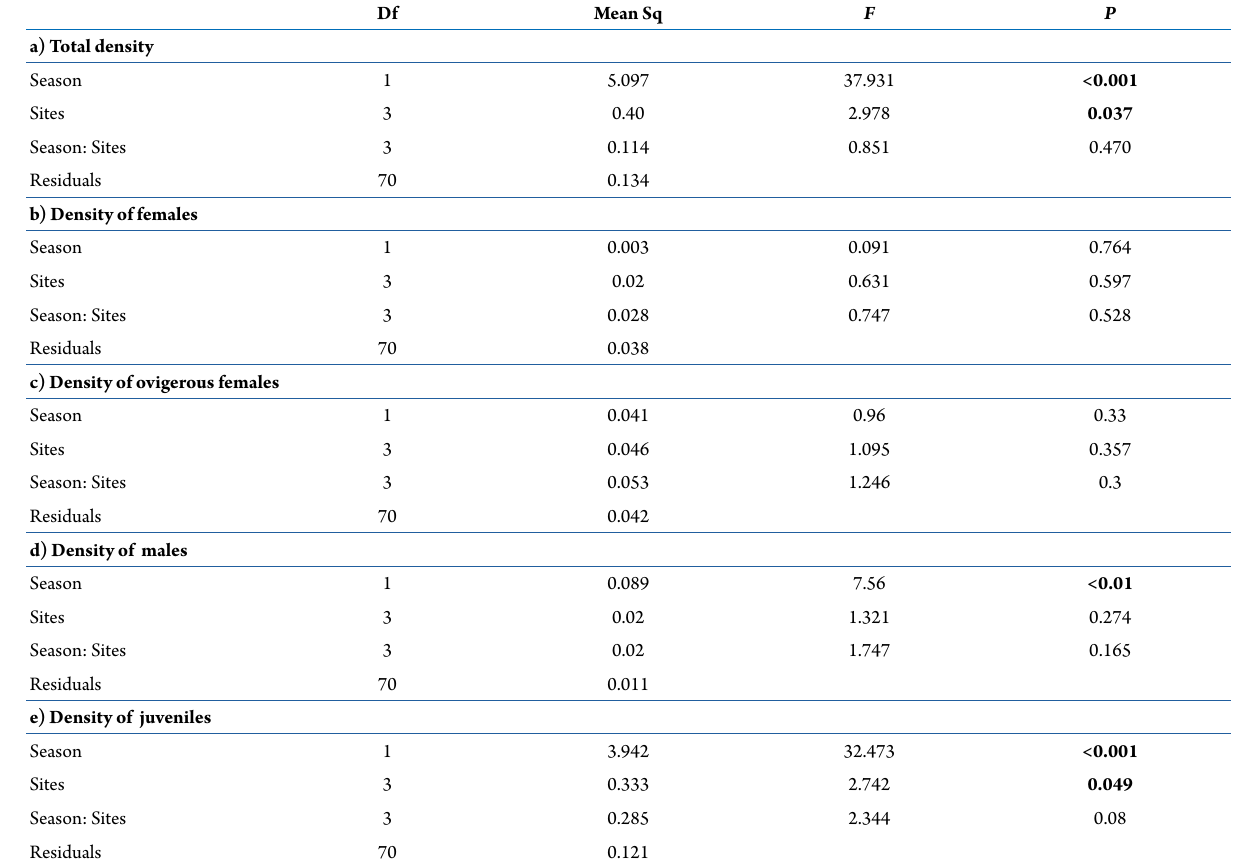
Table 2. ANOVA results for Cymadusa filosa for comparisons of amphipod densities between sites and seasons. ( a ) Total density; ( b ) density of females; ( c ) density of ovigerous females; ( d ) density of males and ( e ) density of juveniles. Bold font indicates significant P values.